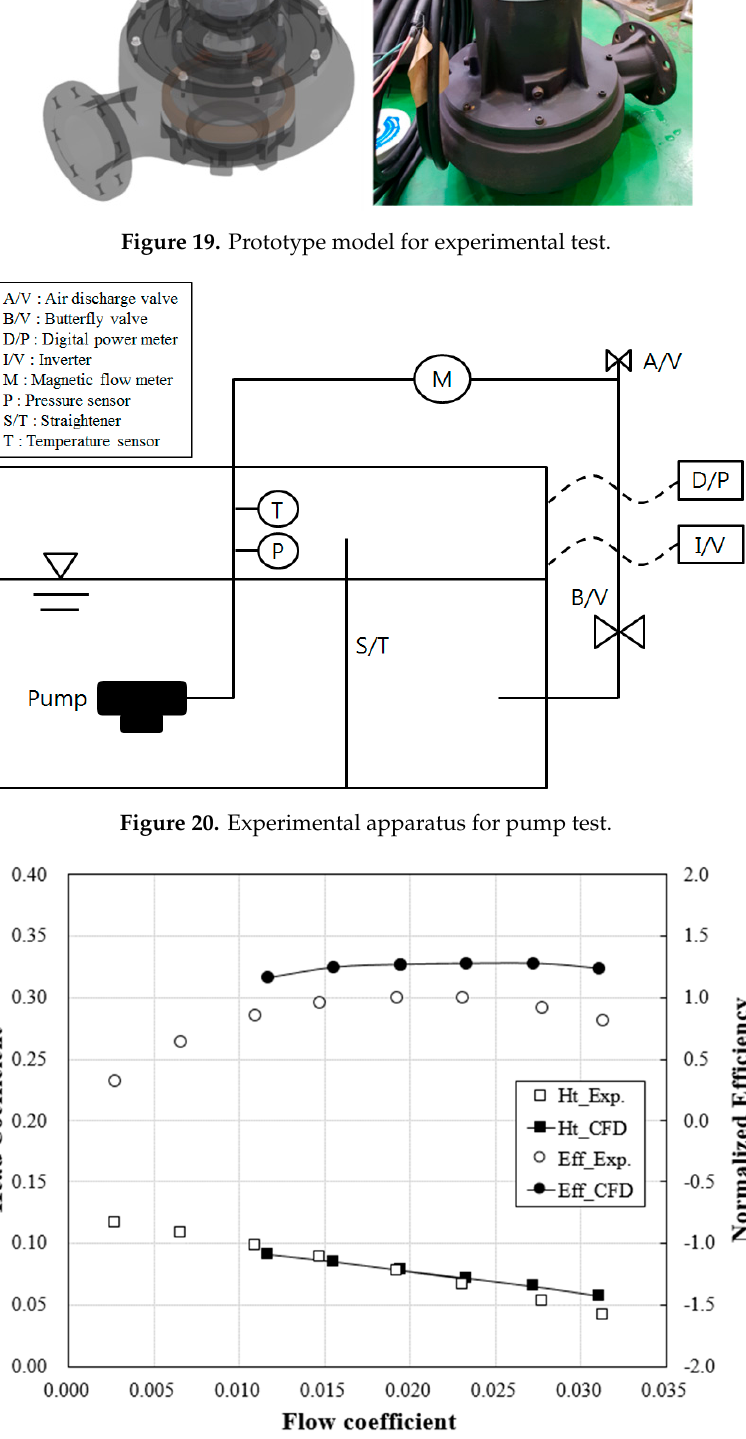
Figure 21. Verification results of prototype model.